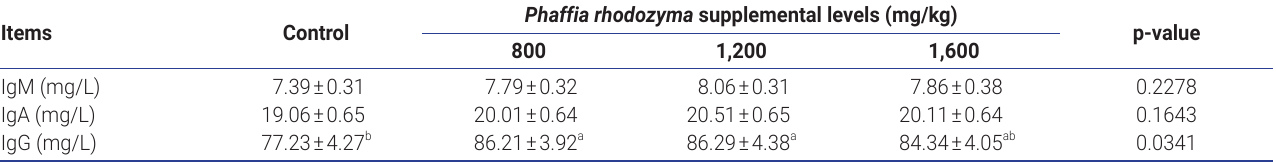
Table 5. Effect of dietary astaxanthin rich Phaffia rhodozyma levels on immune defenses of laying